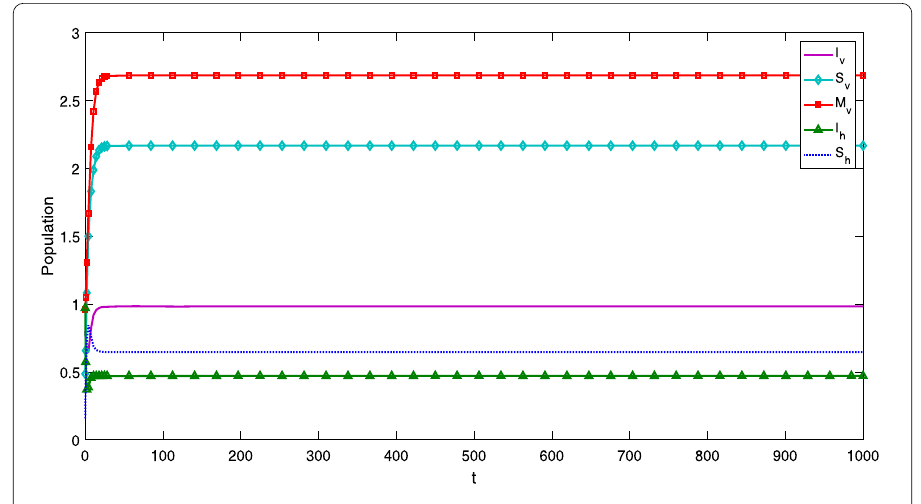
Figure 1 Solution curves of system (2) with parameters given in Example 1